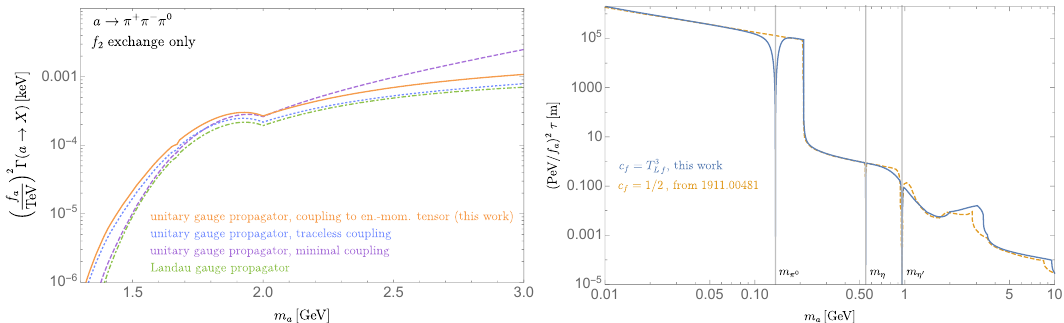
Figure 8 . (Left) comparison of different treatments of the f 2 exchange. For all curves the amplitude is given only by eq. (A.28) with c = T 3 , but different prescriptions for the f couplings and f 2 Lf propagator lead to different expressions for c M . In solid orange, the choice made in this work: f f 2 2 couples to the energy-momentum tensor and has a unitary gauge propagator, leading to eq. (A.29). In dotted blue (dashed purple), alternative versions where the coefficient of the g µν piece in eq. (A.26) is set to − 1 / 4 (0), still with unitary gauge propagator. In dot-dashed green, the version used in ref. [24] where the propagator has the Landau gauge expression, i.e. in eq. (A.30) one replaces m 2 → k 2 . f 2 For this choice, which does not seem justified, the result is independent of the coefficient of the g µν piece in the coupling. (Right) total lifetime obtained from our calculation with ALP-fermion couplings proportional to weak isospin, compared to the lifetime for universal couplings